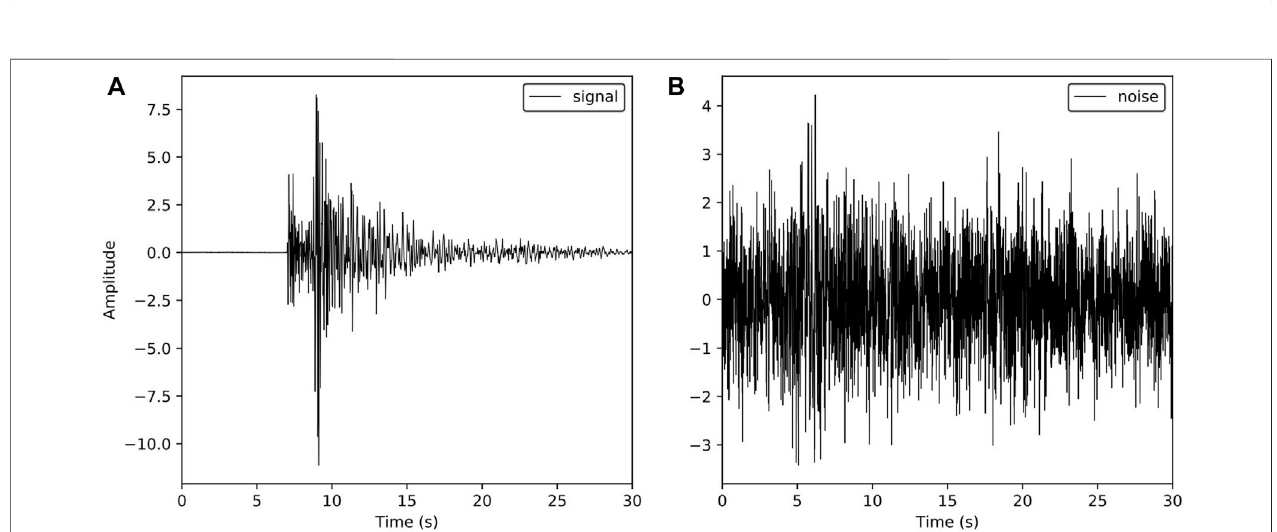
FIGURE 12 | Other types of noise reduction performance. (A,C,E) are the original signals, the noise signal, and the signal after noise reduction in the time domain; (B,D,F) are the time-frequency domain data of (A,C,E) ; the signal SNR after adding noise (cid:1) 0.34 dB, r (cid:1) 0.7125, SNR after noise reduction (cid:1) 13.07 dB, r (cid:1) 0.9822.